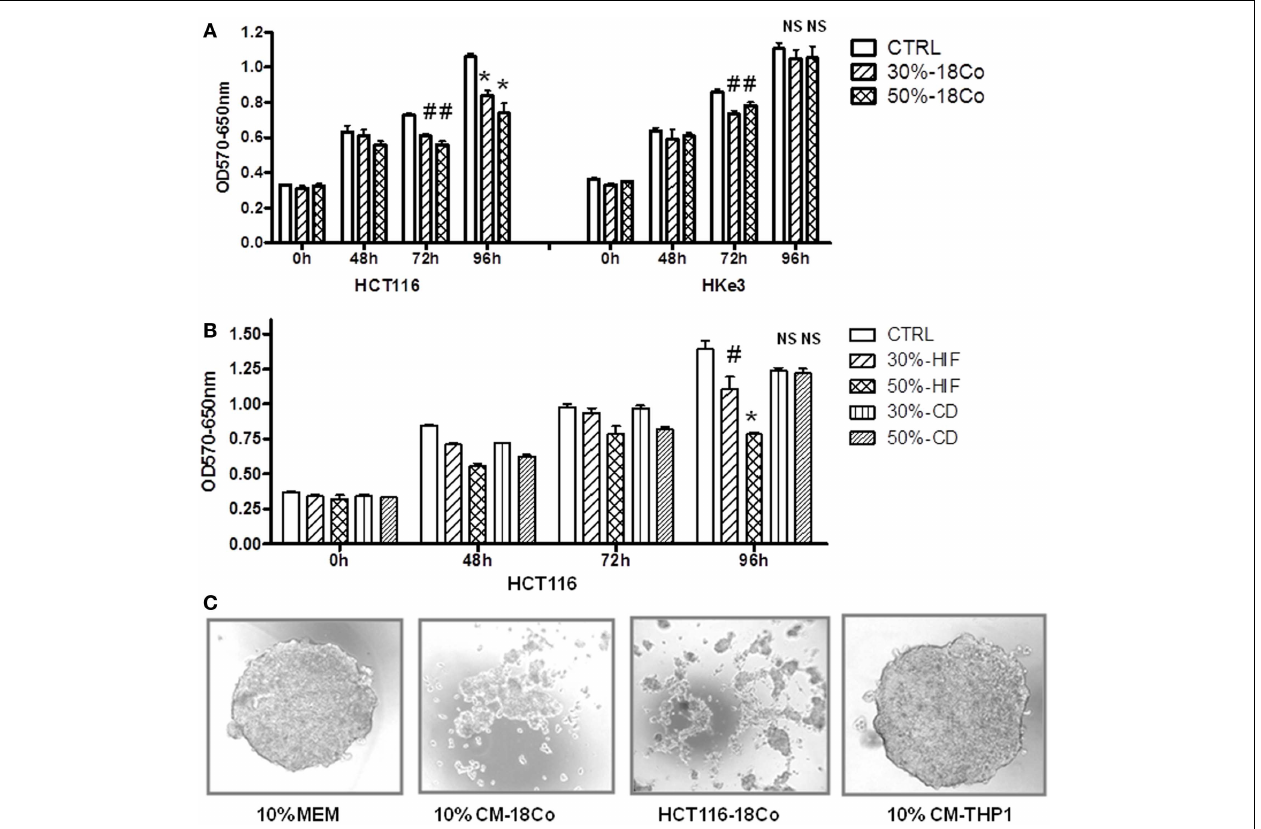
cells were generated using a hanging drop technique. Spheroids were generated using control medium (10% MEM), medium containing 10% conditioned medium from 18Co cells (10% CM-18Co) orTHP1 macrophages (10% CM-THP1). Alternatively, spheroids were generated by combining HCT116 and 18Co cells (HCT116–18Co). # p < 0.05, * p < 0.005, compared to control cells; NS,